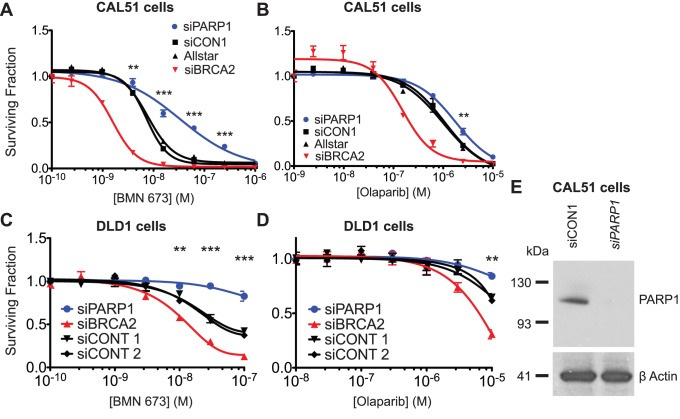

PARP1 depletion by siRNA causes PARP inhibitor resistance in human cells.CAL51 (A, B) or DLD1 (C, D) cells were transfected with the indicated siRNAs and treated with BMN 673 (A, C) or olaparib (B, D). Cell survival assayed using CellTiter Glo and expressed as a proportion of DMSO-treated control is shown on the y-axes. Allstar, siCONT1, siCONT2 are non-targeting siRNA controls. siRNA targeting BRCA2 is included as a positive control known to sensitise cells to PARP inhibition [8]. The mean of five replicates is shown; error bars show SEM. **, P<0.01; ***, P<0.001 for PARP1 compared to non-targeting control (two-way ANOVA with Bonferroni post test). E Confirmation of knockdown of PARP1 protein. Lysates from CAL51 cells transfected with the indicated siRNAs were probed with anti-PARP1 (top) or anti-β-actin (bottom).